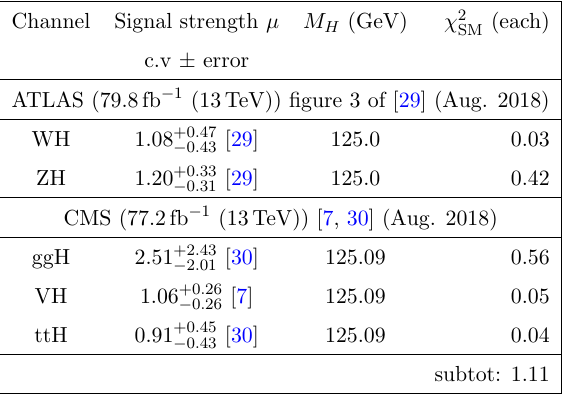
Table 12 . (LHC: 13 TeV) The same as table 9 but for H ! b (cid:22) b .